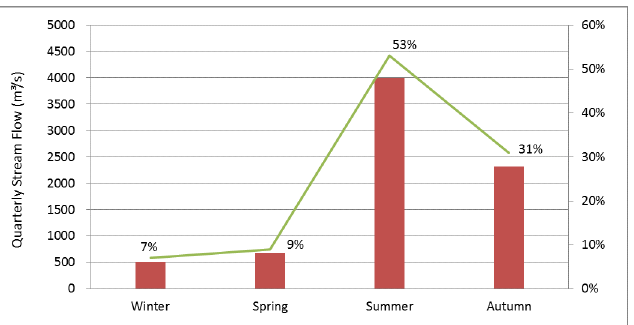
Fig 3. Quarterly streamflow observations at Nuxia hydrological station from 1960 to 2000.